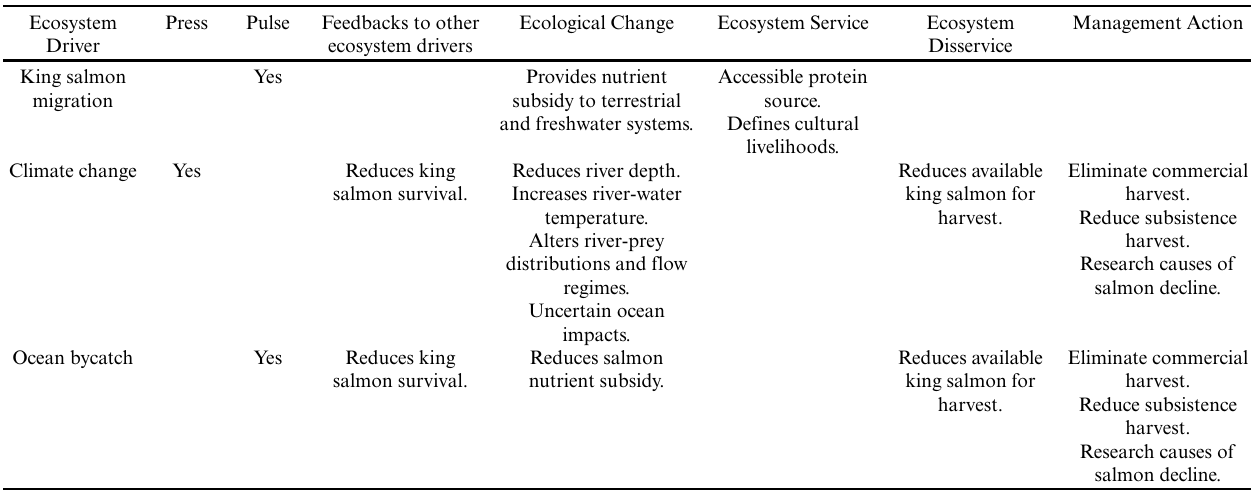
Table 2 . Press- and pulse-ecosystem drivers, feedbacks, ecological change, ecosystem services, disservices, and associated management actions in the Yukon River drainage, Alaska. King salmon ( Oncorhynchus tshawytscha ). Ecosystem Driver